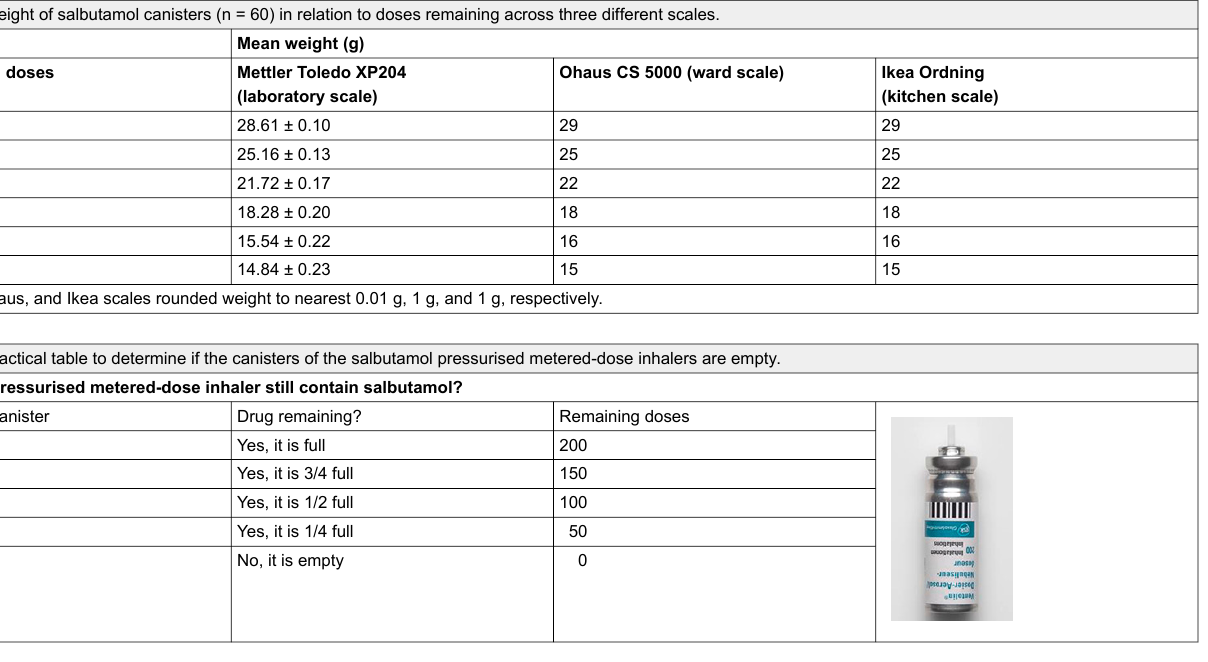
Mean weight (g) (laboratory scale)